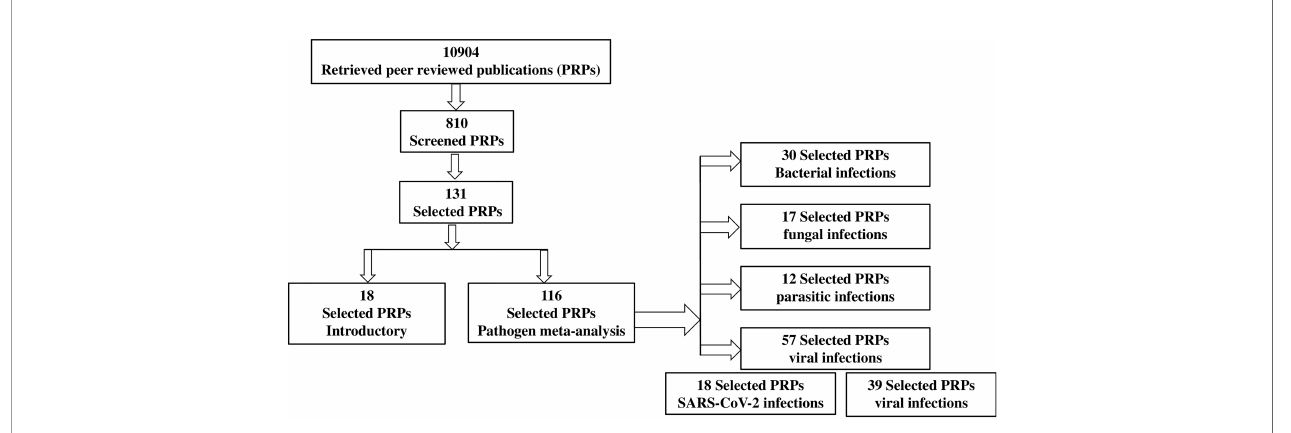
FIGURE 1 | PRISMA fl ow diagram of the systematic review.